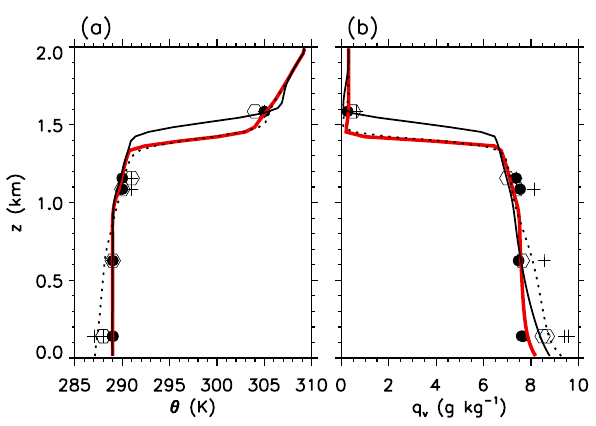
Fig. 12. Vertical profiles of (a) potential temperature θ and (b) wa- ter vapor mixing ratio q v . Black circles, hexagons and plus signs represent RF06 leg-mean measurements for overcast regions, POCs and drizzling boundaries; Red lines are mean profiles during model spin-up time for both D30 and D500; Black solid lines (D500) and dotted lines (D30) are profiles averaged at night between t =3 and